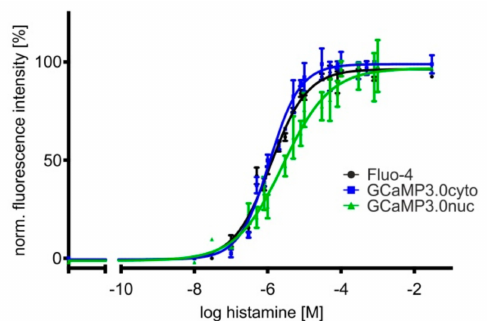
Figure 4. Concentration–response curves of histamine-induced Ca 2+ signals in HEK293 cell lines. Cell lines were established constitutively expressing differently targeted GCaMP3.0 variants. Here, GCaMP3.0cyto and GCaMP3.0nuc expressing cells were compared with parental HEK293 cells loaded with the Ca 2+ -sensitive dye Fluo-4 for monitoring histamine-induced Ca 2+ signals. Cells were seeded into 96 well dishes at a density of 20,000 cells/well. A change in [Ca 2+ ] i was registered as a change in fluorescence intensity (at 510 nm). Fluorescence values were normalized to the highest fluorescence intensity (=100%) obtained at the highest histamine concentration. Each data point (four-fold determination ( ± SD)) was plotted against the corresponding histamine concentration. Experiments were repeated independently at least three times. The concentration–response curves were calculated with GraphPad Prism